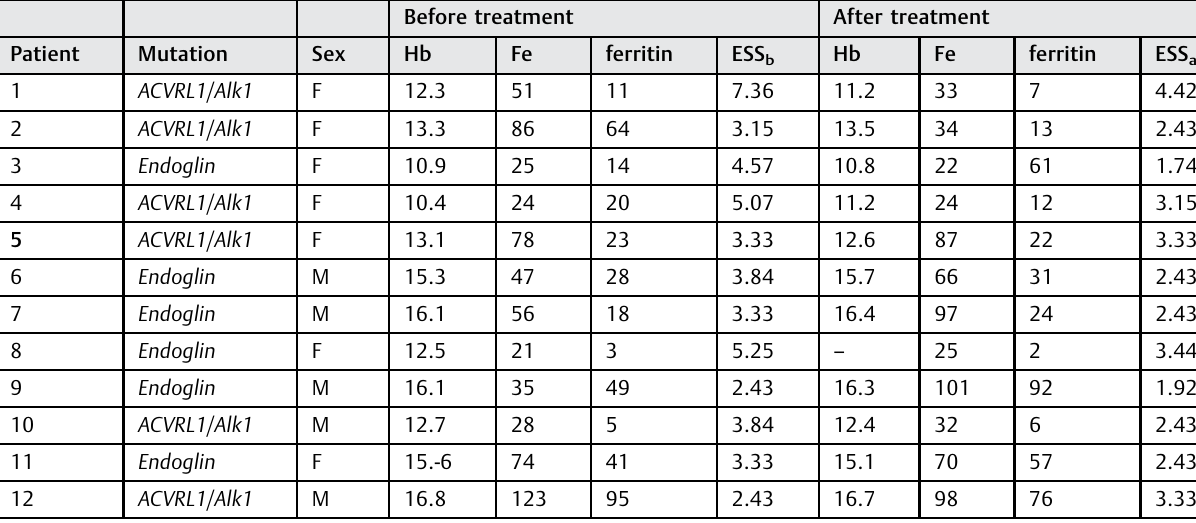
Table 1 Clinical results before and after etamsylate treatment Before treatment After